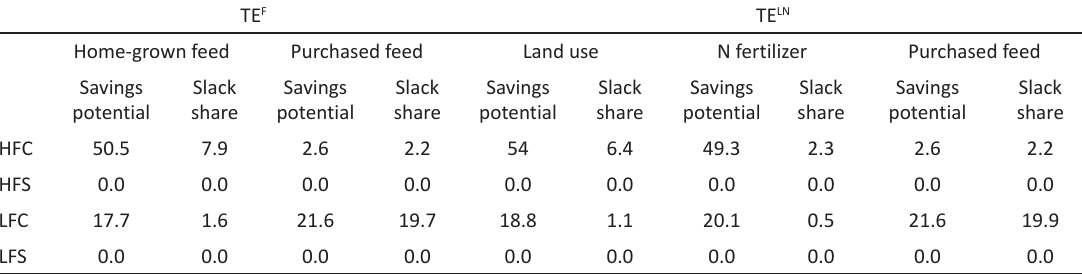
Table 4. Input savings potentials and slack shares per system for the year 2010–2011 TE F TE